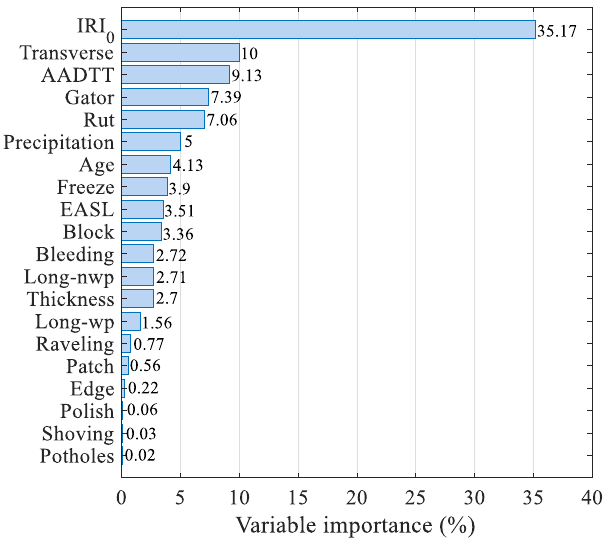
Figure 10. Importance of input variables.